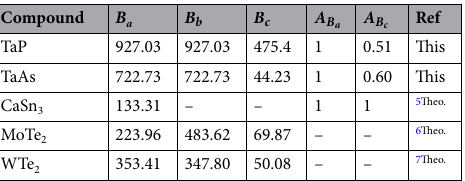
Table 5. Anisotropies in bulk modulus along different crystallographic axes of TaP and TaAs compounds. Relevant data for some other WSMs are also shown.